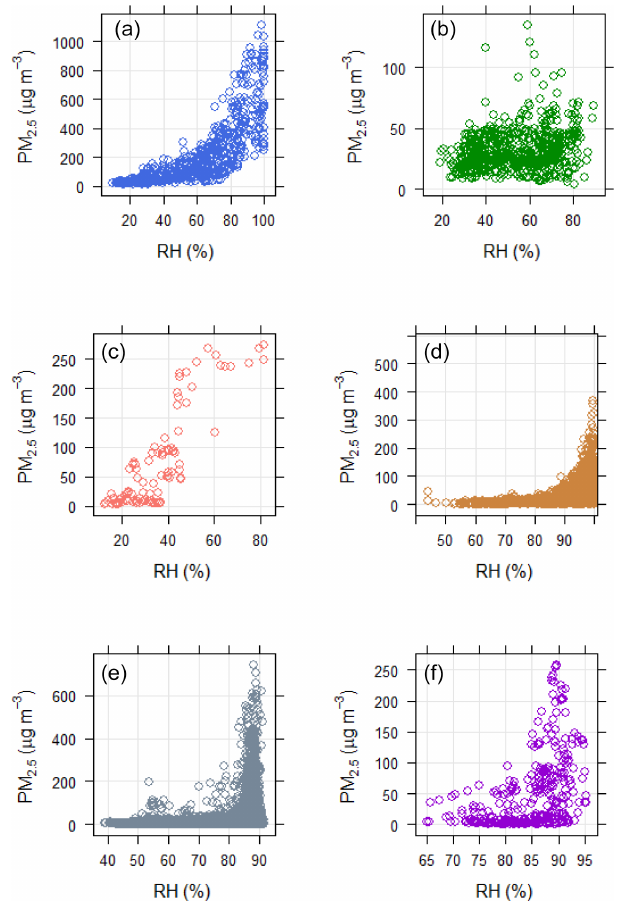
Figure 3. Derived OPC-N2 uncorrected PM 2 . 5 mass concentrations against TEOM PM 2 . 5 mass concentration measurements coloured by ambient RH (a) and the fraction of sulfate to the total PM 2 . 5 mass (b) in Beijing. The straight line indicates the linear regression fit for concentrations below 150µgm − 3 . The dashed line is the 1 : 1